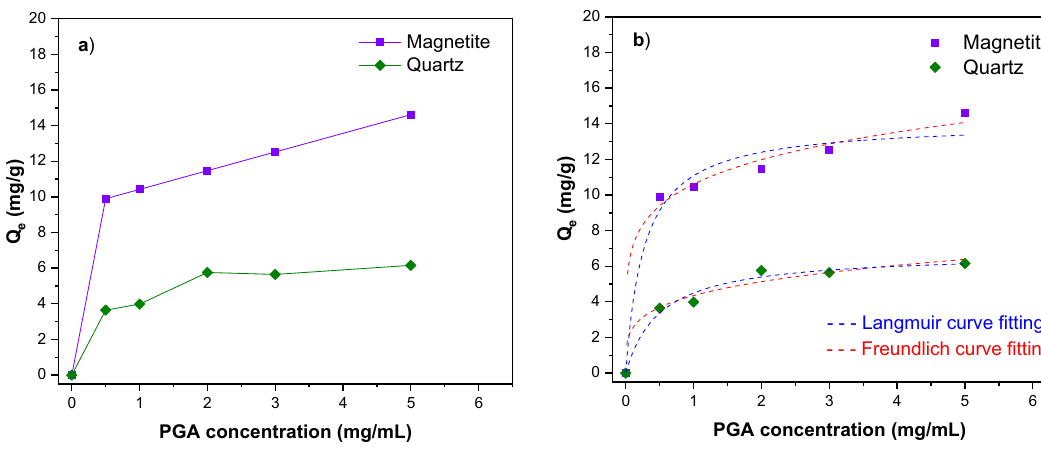
Figure 9. Adsorption of PGA as a function of initial concentration at pH 10. Langmuir Particles